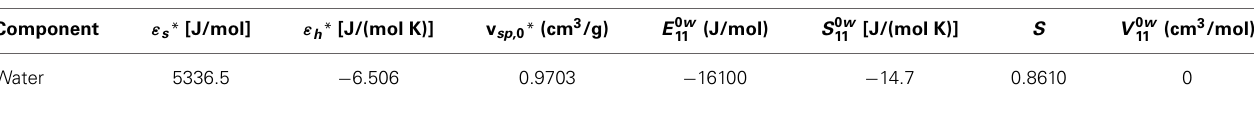
Table 7 | NRHB model parameters for pure